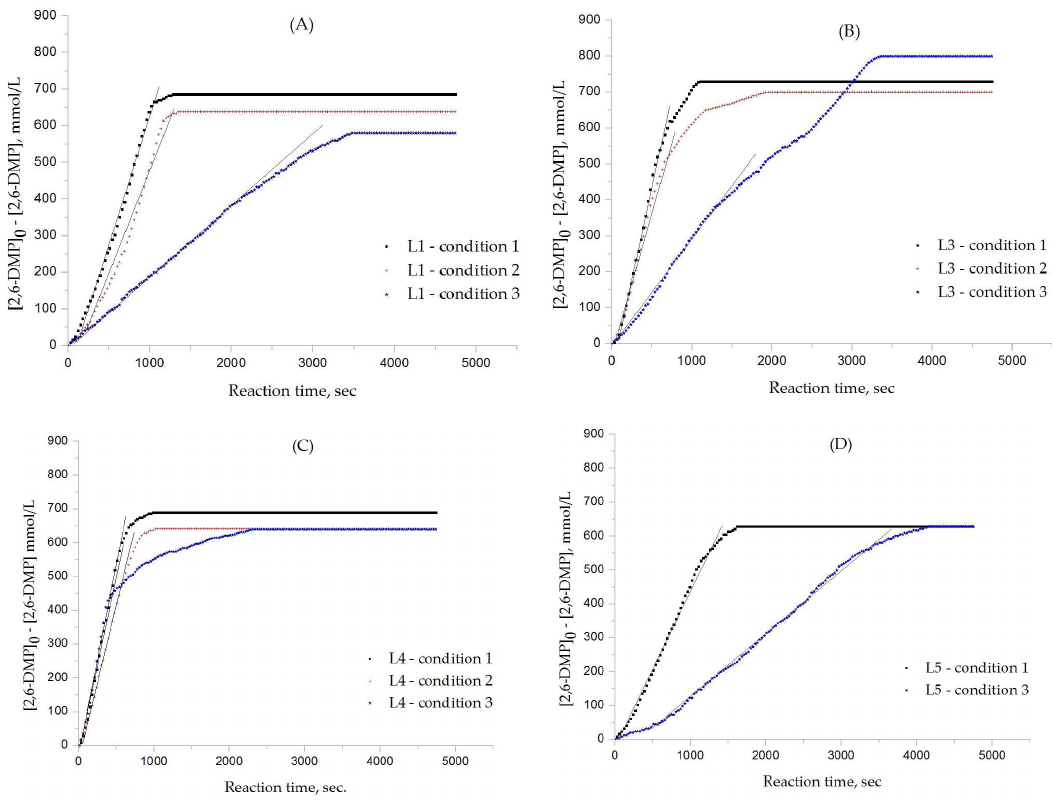
Figure 3. Plots of decrease in molar concentration of 2,6-DMP (mmol/L) versus reaction time (s): ( A ) for L 1 ; ( B ) for L 3 ; ( C ) for L 4 ; ( D ) for L 5 .